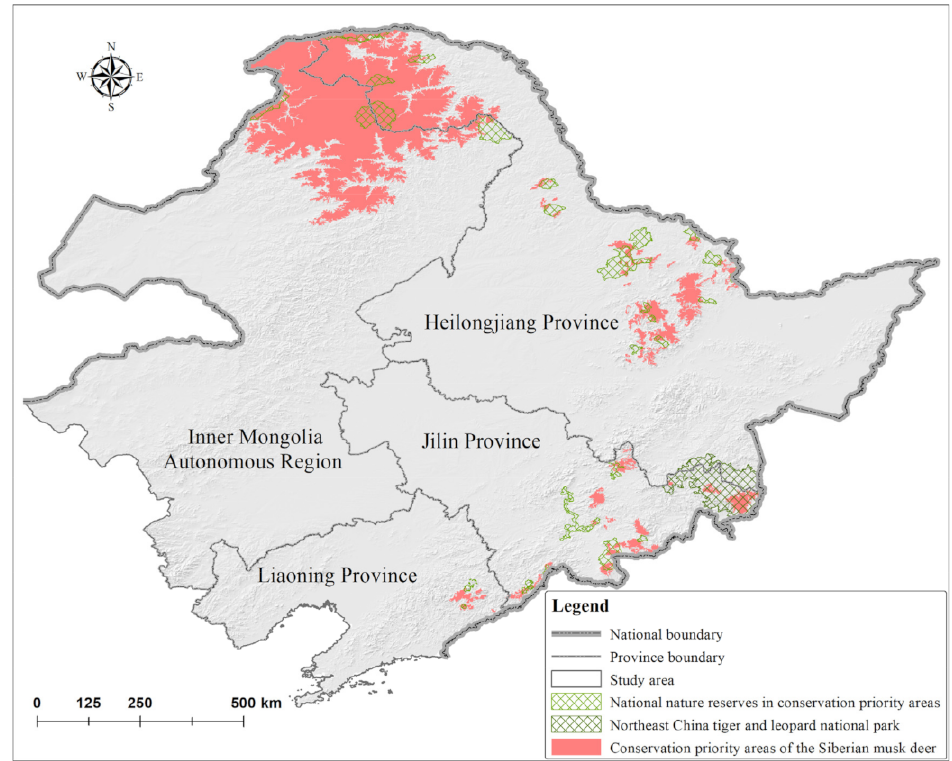
Figure 3. Conservation priority areas and conservation status of M. moschiferus (For basic information on protected areas, see Supplementary Materials: Table S3).